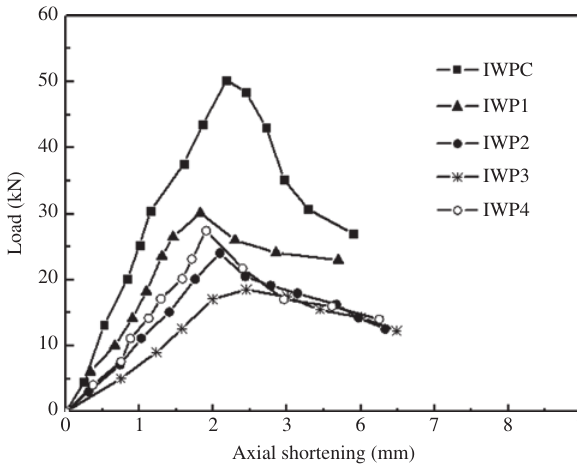
Figure 16: Load-axial shortening curves for specimens in Group